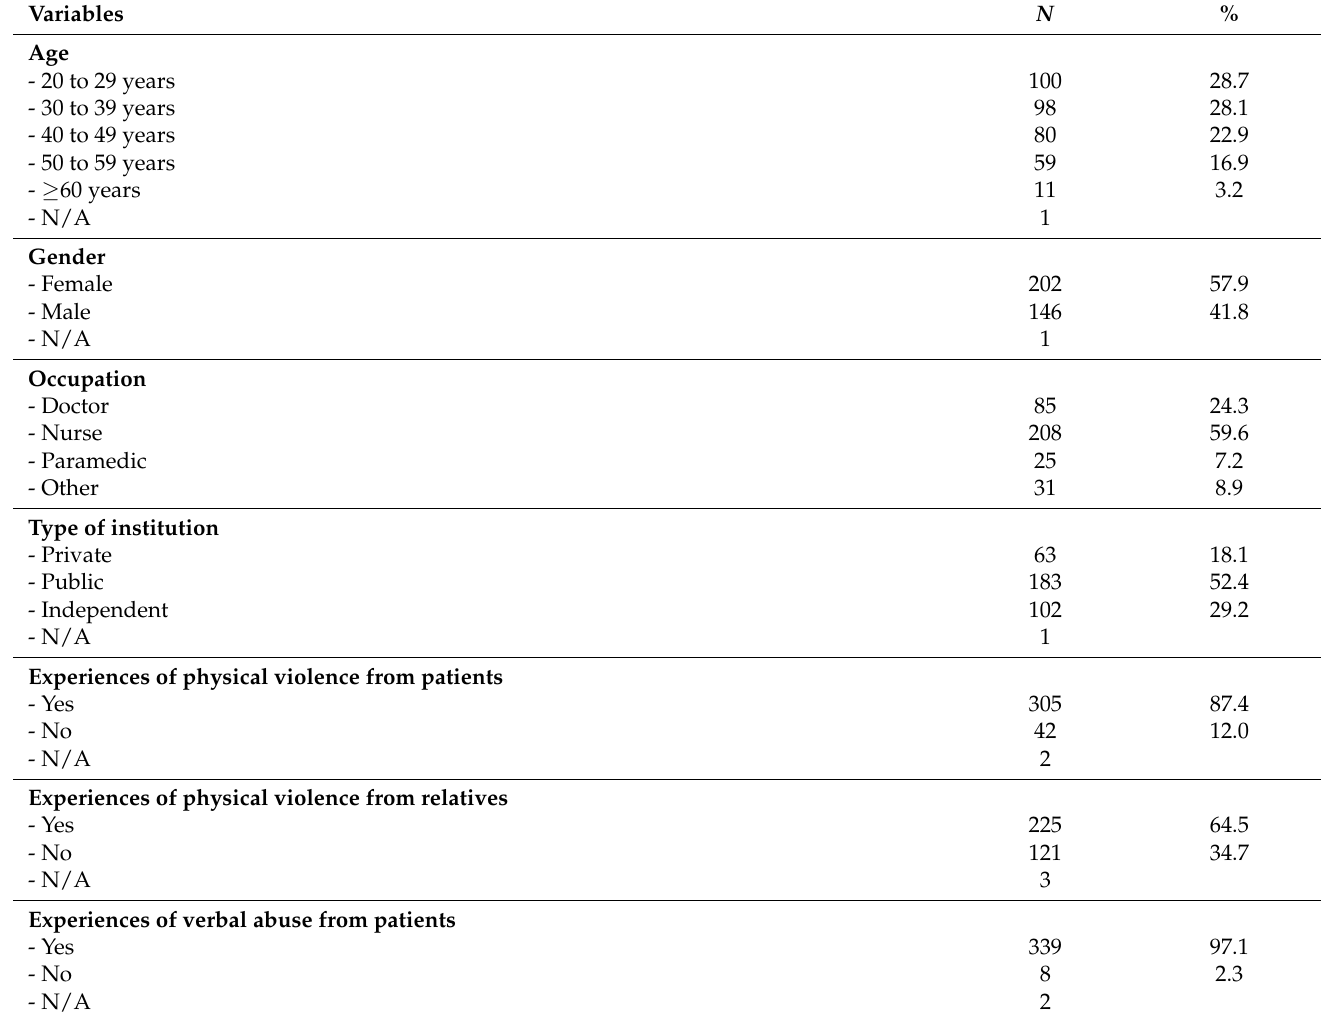
Table 2. Description of the study population ( n =